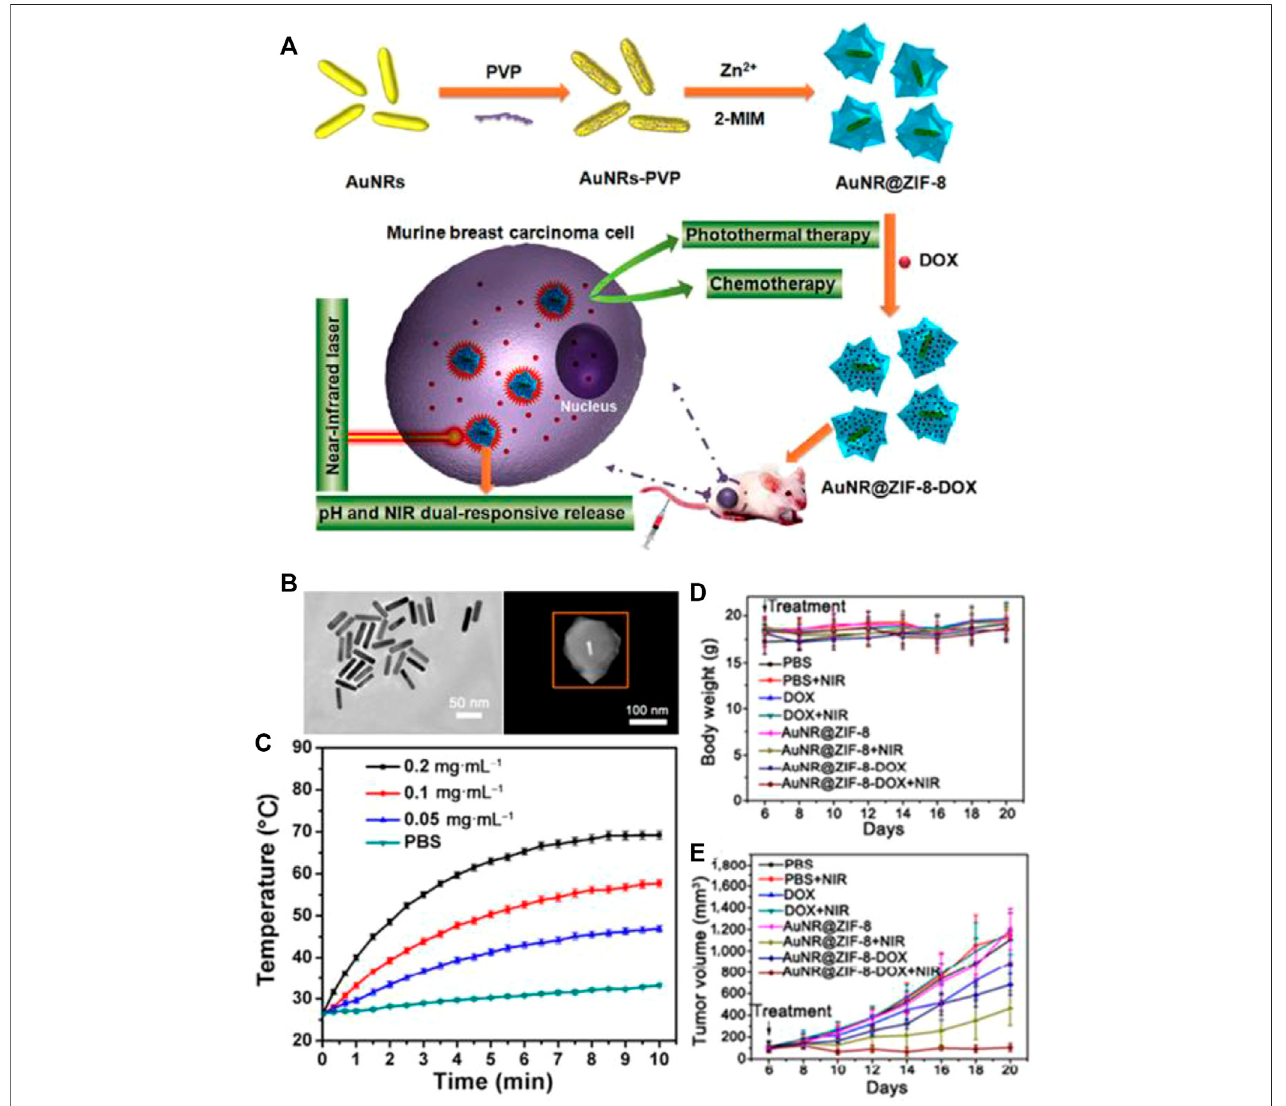
FIGURE1|(A) SchematicrepresentationoftheAuNRs@ZIF-8core – shellnanostructures. (B) TEMimageofCTAB-stabilizedAuNRsandHAADF-STEMimageof single Au NRs@ZIF-8 core shell nanostructure. (C) The temperature increased by Au NRs@ZIF-8 core – shell nanostructures in PBS solution l. (D,E) Observation of changesin (D) bodyweightand (E) relativetumorvolumefrom4T 1 tumor-bearingmicewithdifferenttreatments.Reproducedwithpermission(Lietal.,2018).Copyright 2018, Nano